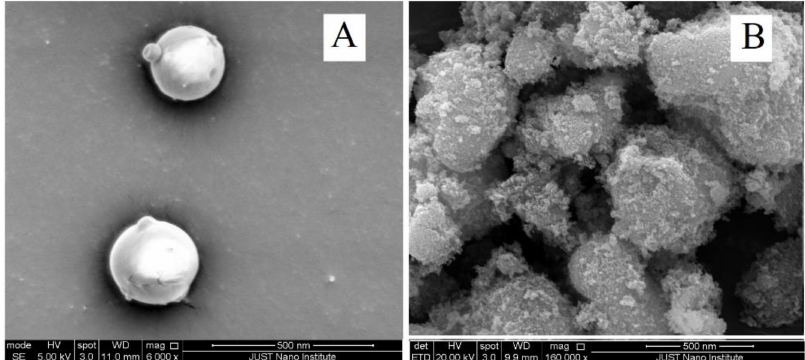
Figure 1. SEM image of MTX-CS-NPs ( A ) uncoated NPs, ( B ) coated NPs with TiO 2 -NPs (F 1 ). FTIR results for CS, MTX, TiO 2 -NPs, MTX-CS-NPs, the physical mixture (MTX-CS- NPs with TiO 2 -NPs) and MTX-CS-NPs coated with TiO 2 -NPs are shown in Figure 2. First of all, the spectra of CS, MTX and MTX-CS-NPs were compared to detect the formation of CS-MTX NPs. Then the spectrums of TiO 2 -NPs, MTX-CS-NPs, the physical mixture and the coated MTX-CS-NPs were compared to explore the coating of MTX-CS-NPs with TiO 2 -NPs.